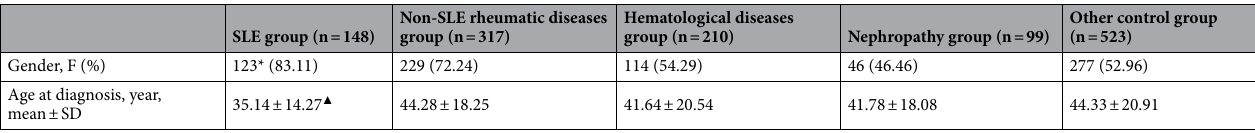
Table 1. The demographic characteristics between groups. *p < 0.05, compared with Non-SLE rheumatic diseases group, Nephropathy group, Hematological diseases group, and Other control group. ▲ p < 0.01, compared with Non-SLE rheumatic diseases group, Nephropathy group, Hematological diseases group, and Other control group. SLE systemic lupus erythematosus.